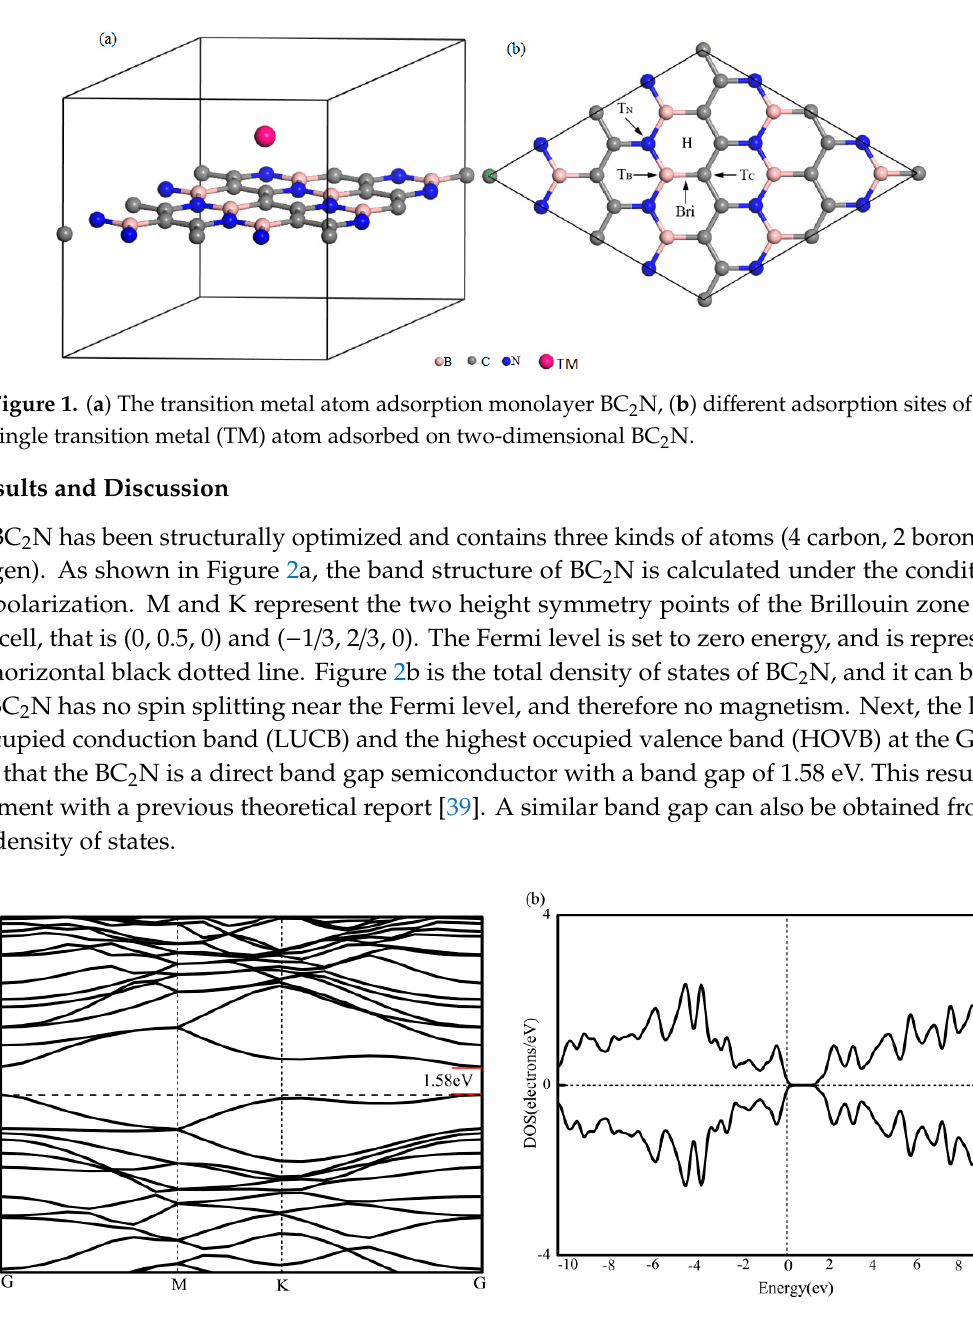
Figure 2. ( a ) The band graph of BC 2 N, and ( b ) The density of states of BC 2 N.